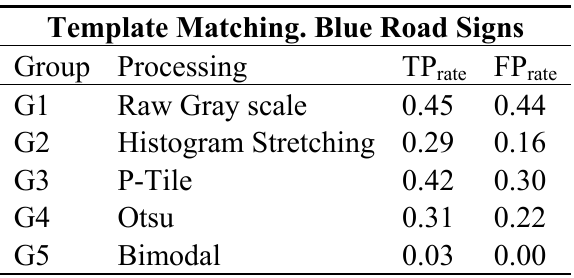
Table 3. Results on recognition of red road signs regarding the processing applied to the